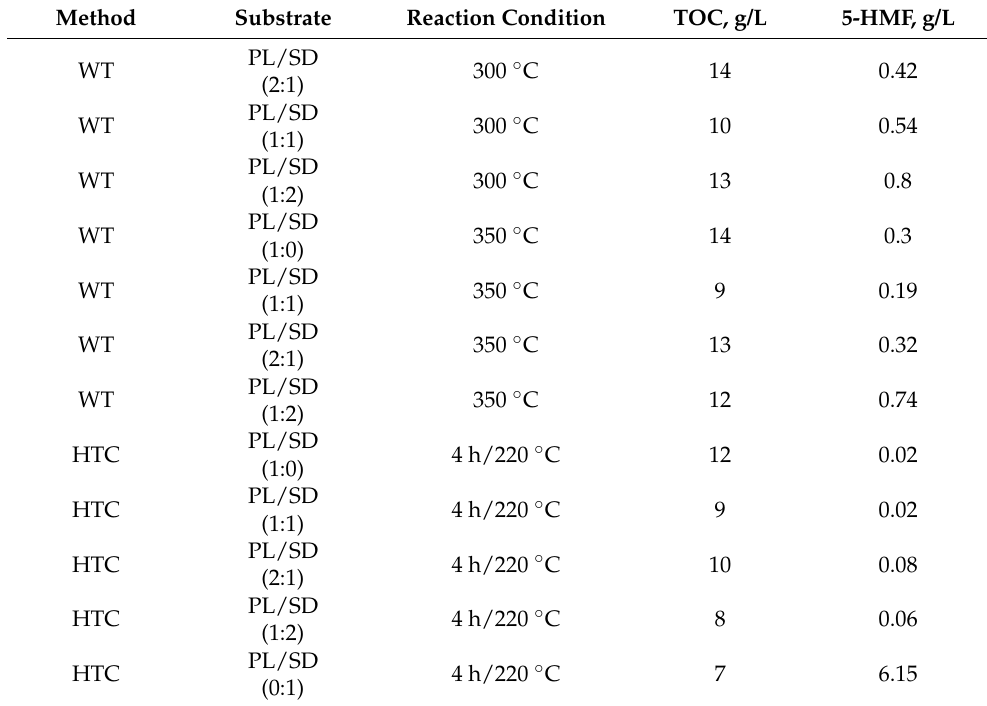
Table 2. Composition of the liquid products of WT and